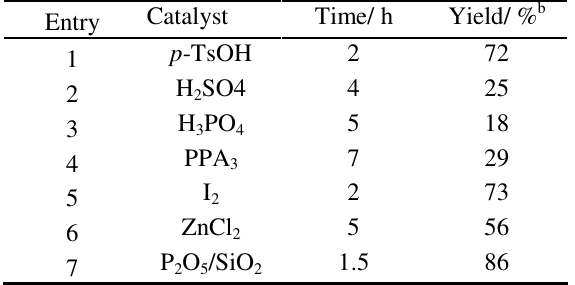
Table 4. Effect of catalysts on the reaction of benzaldehyde and 4-hydroxycoumarin